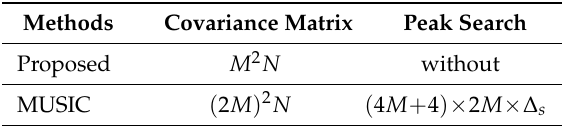
Table 1. Comparison of computational complexity of two